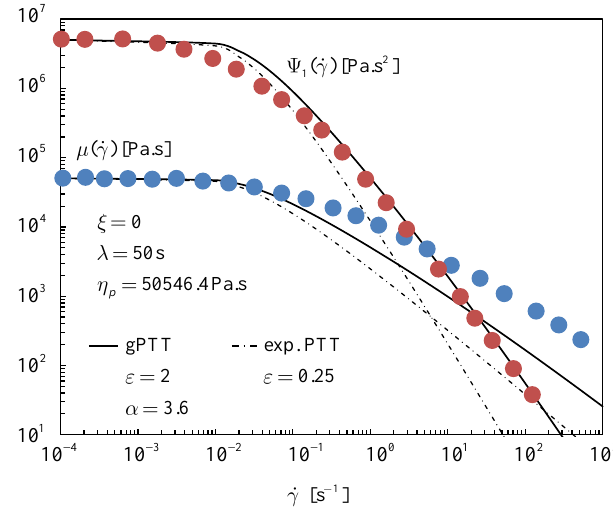
Figure 2. Fitting of the shear viscosity and the first normal stress difference coefficient to rheological data from Laun [7]. The generalised PTT model only considers the one-parameter Mittag–Leffler function, E α . By adding only one parameter, we obtain a fitting error (Equation (17)) of 29.7 and 6 for the exponential and gPTT models, respectively. The symbols represent the experimental data from Laun [7] for a low density polyethylene